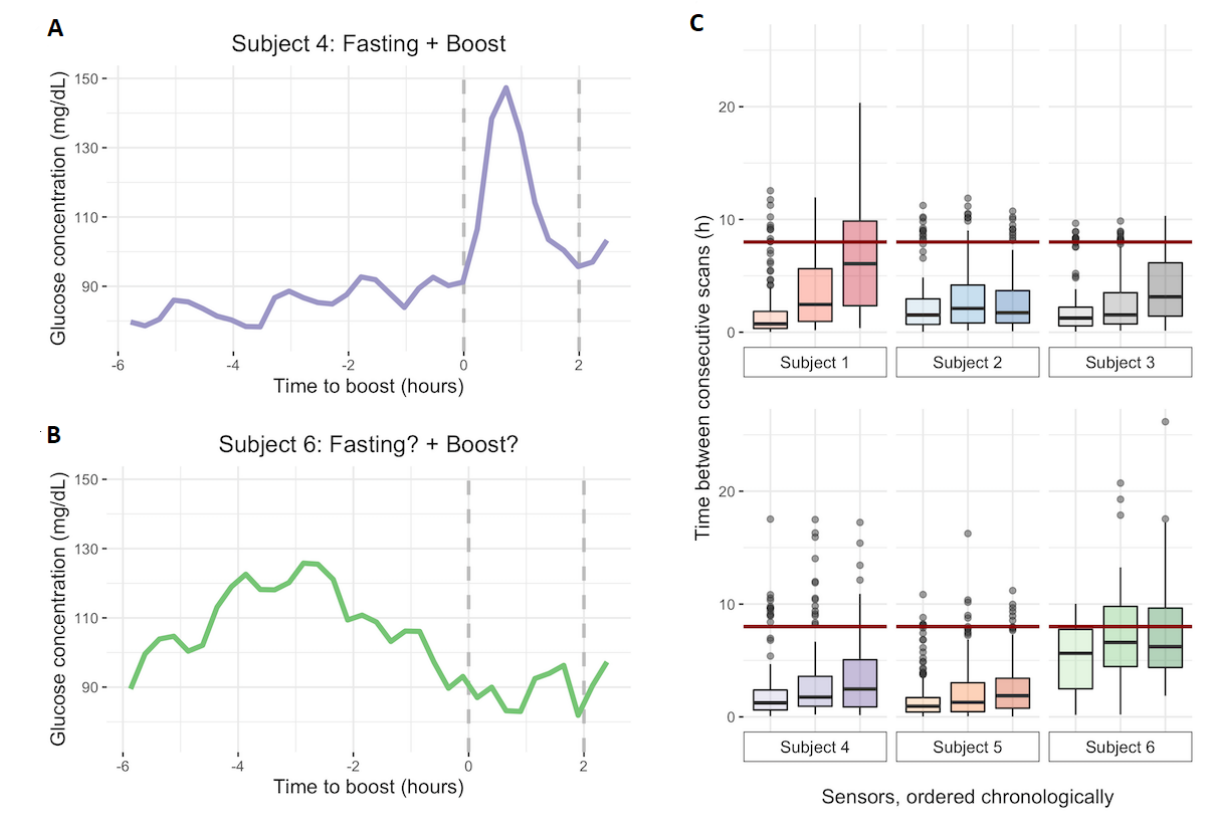
Figure 3. Continuous glucose monitoring (CGM) devices provide insight into compliance. (A) CGM data are concordant between when Subject 4 mentioned fasting/consuming the standardized meal for the glucose challenge and what was detected from the CGM device. (B) CGM data can also be used to detect anomalies. There is no concordance between when Subject 6 recorded fasting/consumption of the standardized meal and what was observed from the CGM data. (C) Each subject is asked to obtain data at regular intervals and at least every 8 hours (red line), which is the limit for the sensor memory to store